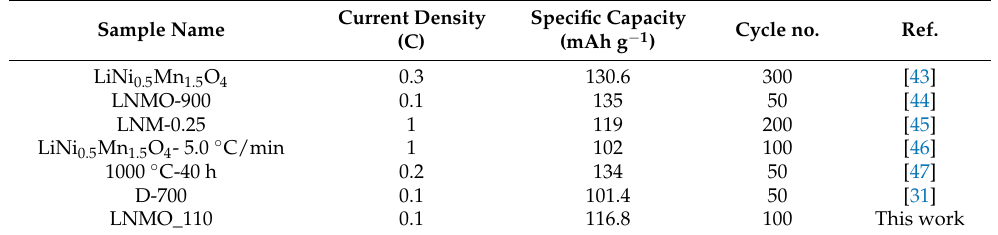
Table 2. Electrochemical performance comparison with previously reported pure LNMO